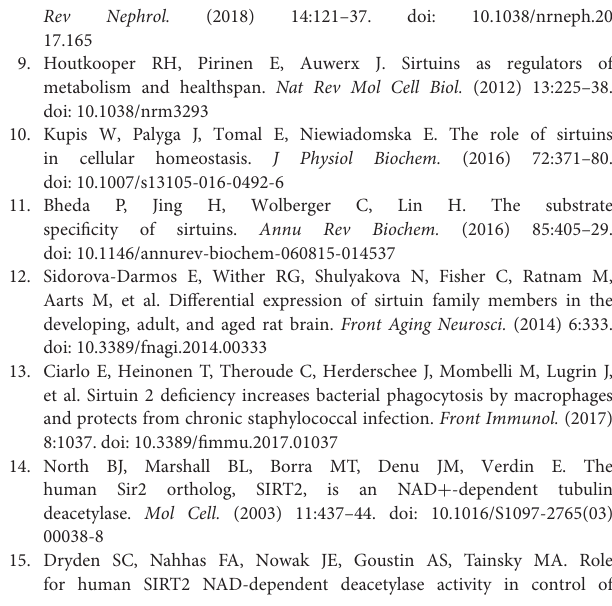
Supplementary Figure 1 | Full blots used to create Figure 1 . Supplementary Figure 2 | mRNA expression levels of phagocytic receptors by resting BMDMs. ItgaM, Itgb1, Itgb2, Itga5, and ItgaX mRNA levels were quantified by RT-qPCR and normalized to actin mRNA levels. Data are mean ± SD of four mice analyzed in triplicate. Supplementary Figure 3 | Gating strategies for flow cytometry